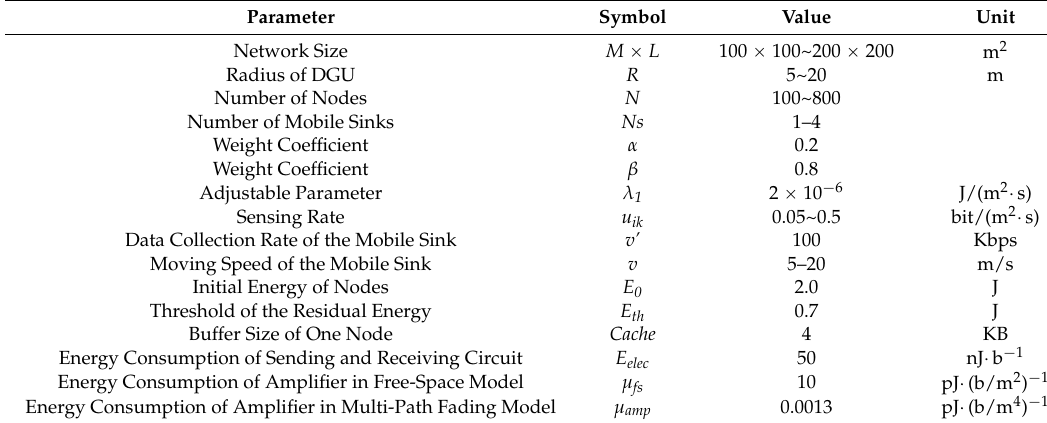
Table 1. Parameter values in